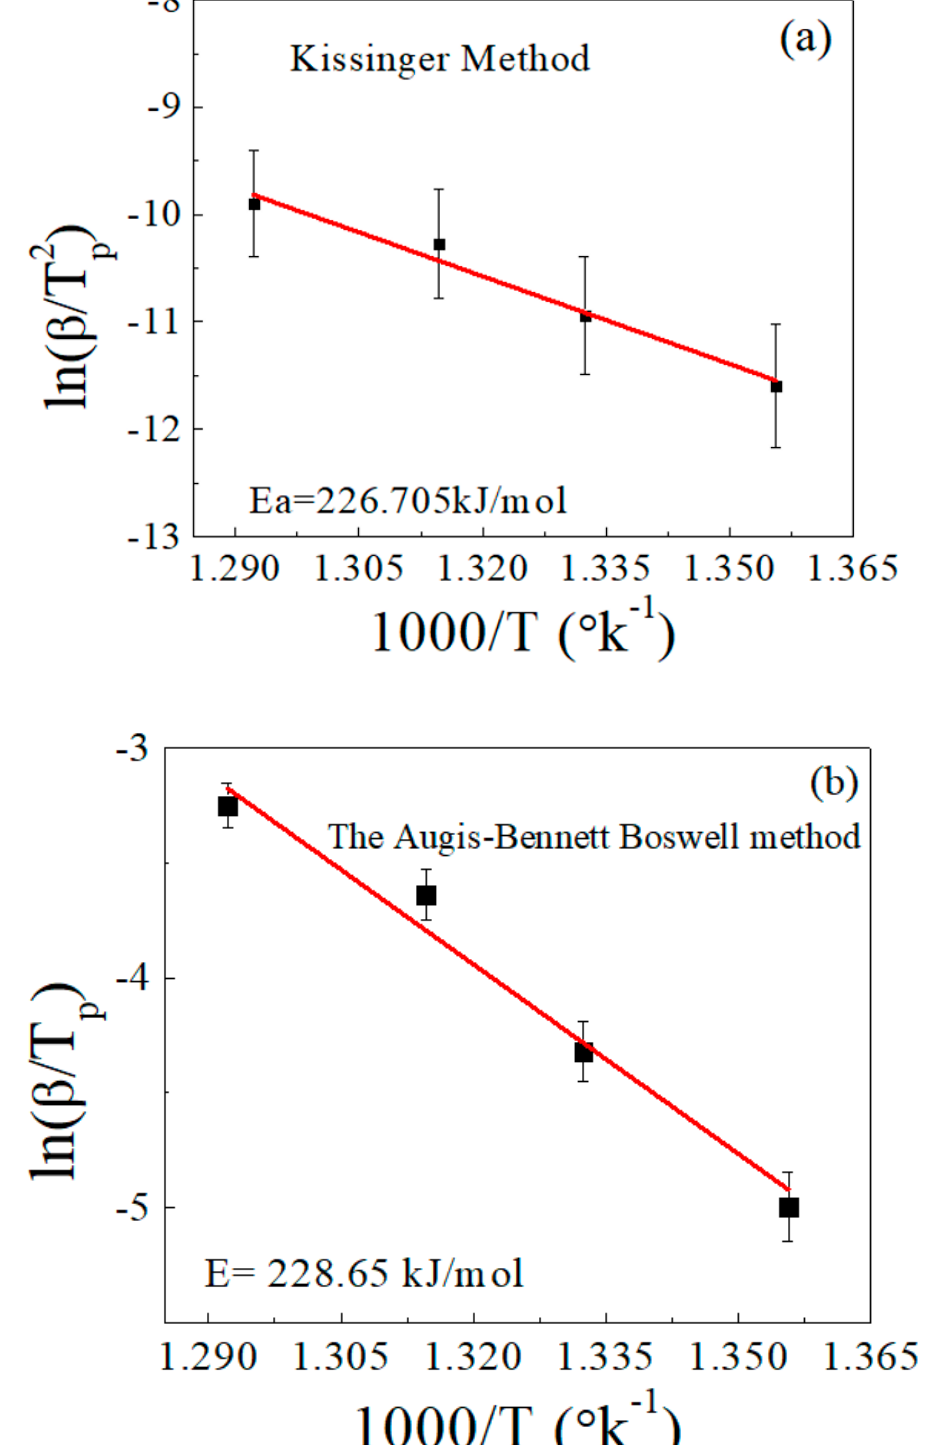
Figure 5. Determination of the activation energy (Ea) in accordance with ( a ) the Kissinger method and ( b ) the Augis–Bennett/Boswell method.